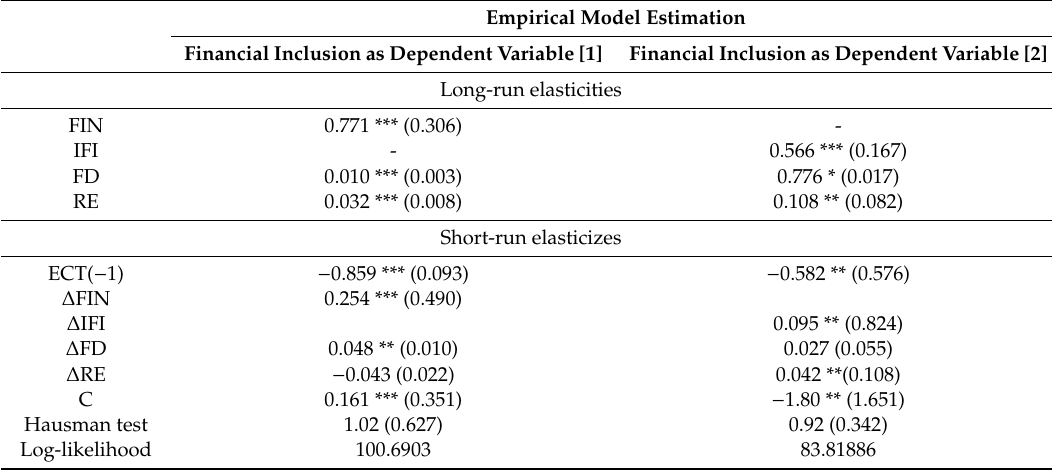
Table 6. Model estimation results without